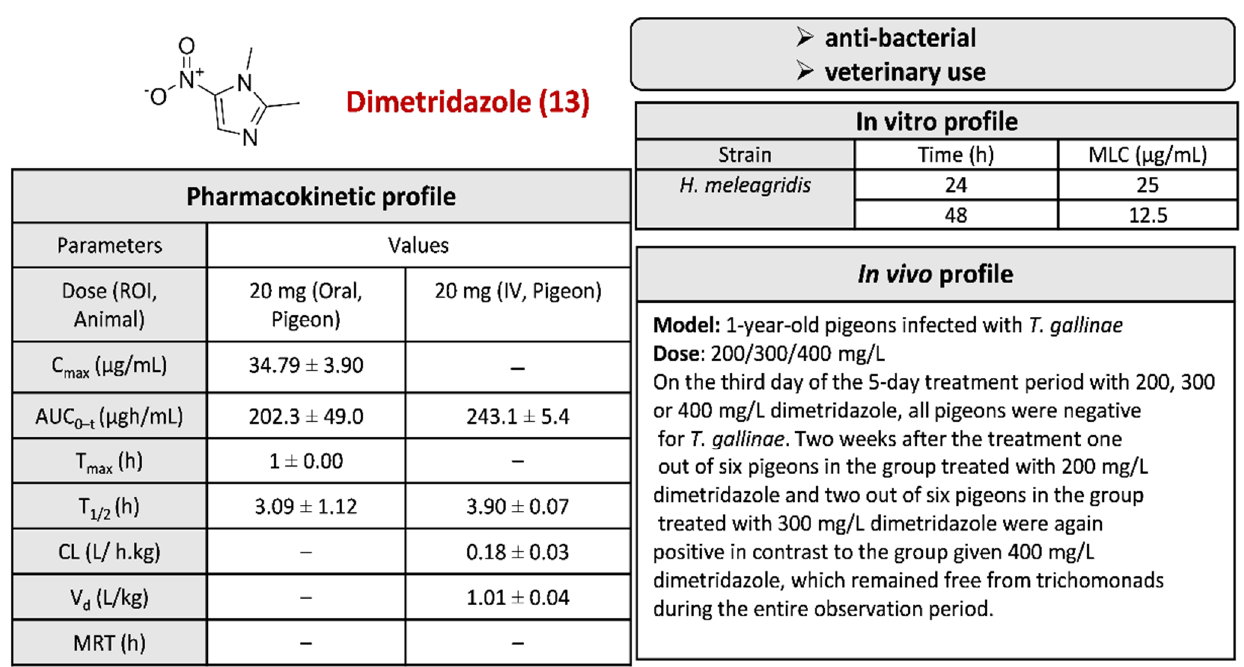
Figure 17. Activity profile of Dimetridazole 13 [133,134]. As shown in Scheme 36, in 2013, the first attempt to synthesize dimetridazole 13 was performed by refluxing 2-methyl-4-nitroimidazole with dimethyl sulfate (route A) [135]. In 2017, Estrada et al. from Denali Therapeutics INC (US) synthesized Dimetridazole 13 by treating 2-methyl-4-nitroimidazole with methyl iodide (route B) [136]. Later, in 2018, Yao, F. et al. developed a new method to synthesize Dimetridazole 13 (route C) by re- acting 2-methyl-4-nitroimidazole with dimethyl sulfate at a better yield (87%) [137].